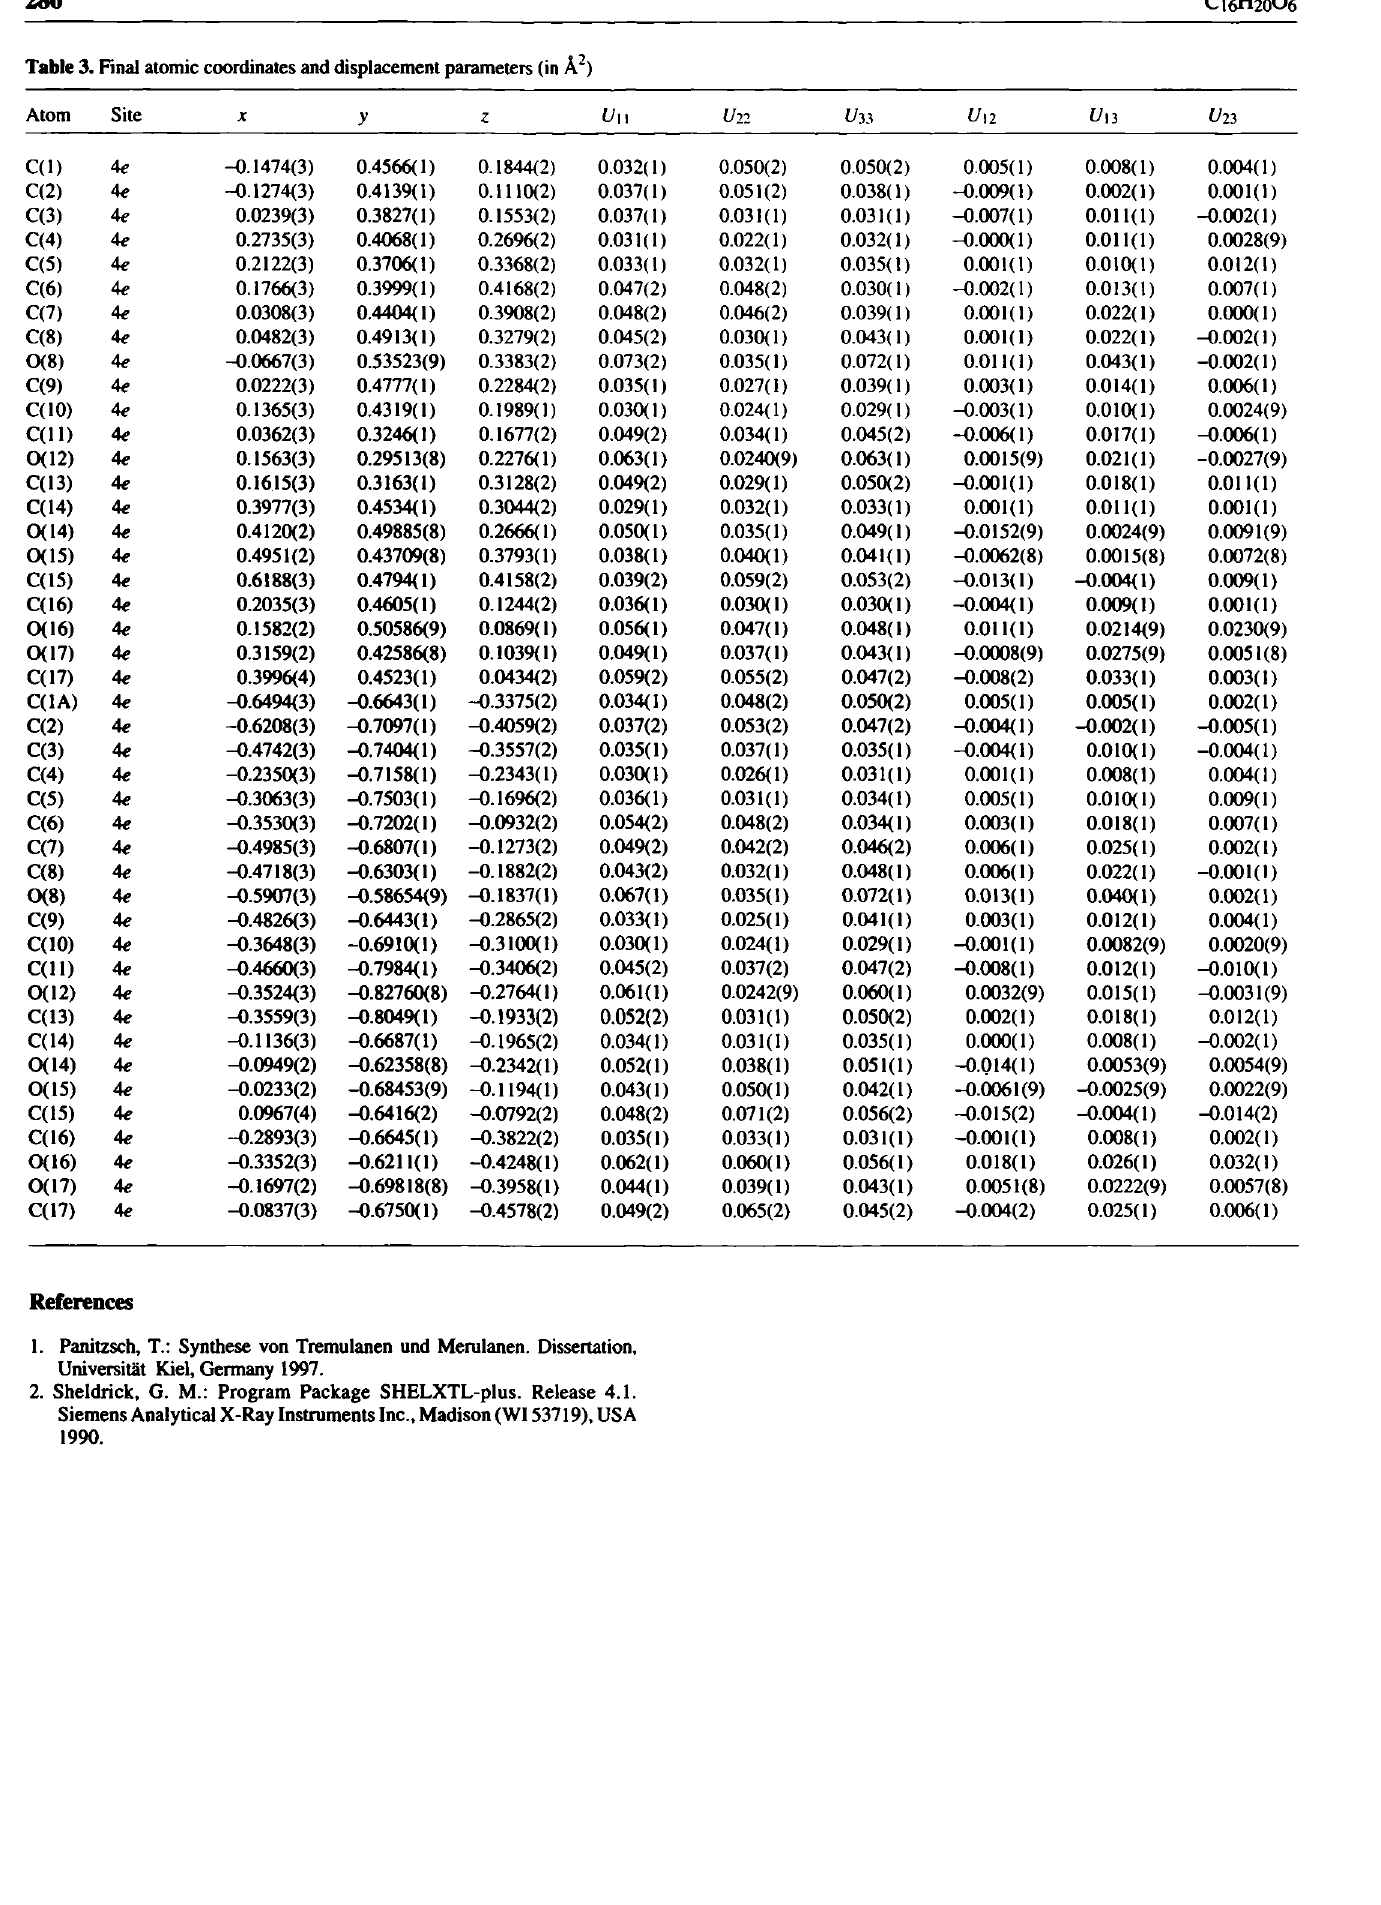
Table 3. Final atomic coordinates and displacement parameters (in